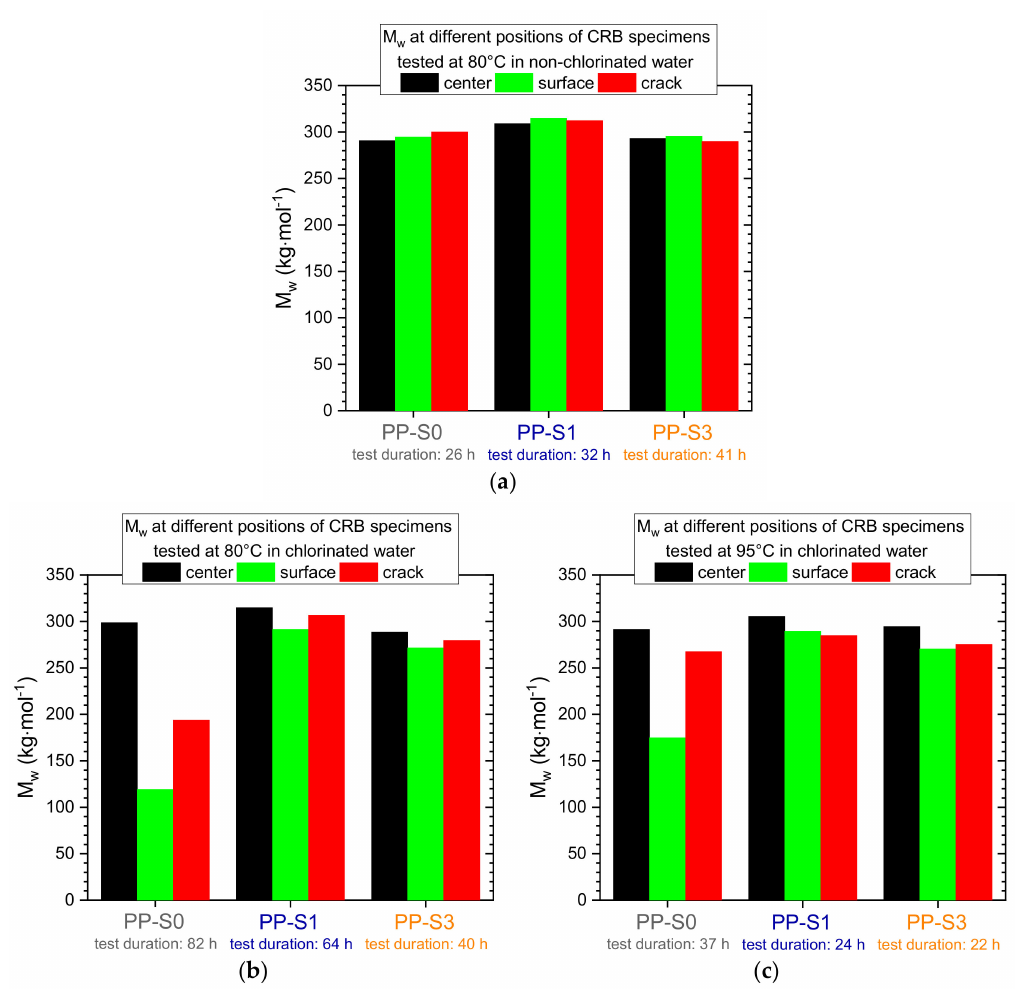
Figure 6. Mean weight average molar masses ( M w) of samples taken from three di ff erent positions in CRB specimens of PP-S0, PP-S1, and PP-S3, which were tested under superimposed mechanical-environmental conditions. The fatigue crack growth tests were performed at ( a ) 80 ◦ C in non-chlorinated water (0 mg / L free chlorine); ( b ) 80 ◦ C in chlorinated water (5 mg / L free chlorine); and ( c ) 95 ◦ C in chlorinated water (5 mg / L free chlorine). The total FCG test duration is also indicated. By comparison, the local alterations in the Mw values of samples taken from the surface and crack positions compared to the center position of the long-term stabilized PP grades PP-S1 and PP-S3 are much less pronounced. While this provides clear evidence of the stabilization e ff ectivity in terms of retarding local molecular degradation under chlorinated water conditions at elevated temperatures in these latter two materials, the data do reveal some local molecular degradation even for these long-term stabilized materials. For example, comparing the crack position to the center position of failed CRB specimens of PP-S1 and PP-S3, for both materials, Mw reductions of about 3% and 7% were ◦ ◦ detected for tests in chlorinated water at 80 C and at 95 C, respectively. In this case, it must be kept in mind that the overall test duration to generate FCG curves for PP-S1 and PP-S3 was shorter than the test time for PP-S0. Moreover, when focusing on the ultra-high molar mass fraction of the molecular mass distribution with molar masses above 3000 kg / mol, the analysis of the local aging states of surface ◦ ◦ and crack samples of tests in chlorinated water at 80 C and 95 C, respectively, revealed a reduction of this ultra-high molar mass fraction by about 9% and